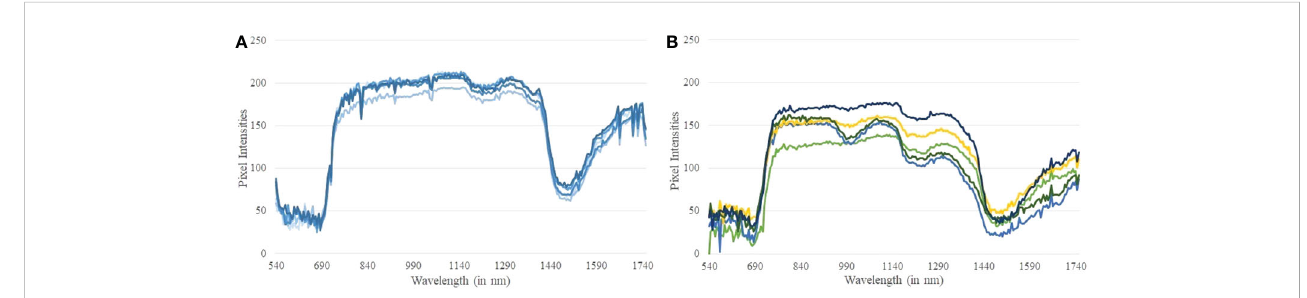
FIGURE 8 (A) Re fl ectance spectra generated at random pixels of a controlled plant; and (B) Re fl ectance spectra generated at random pixels of a stressed